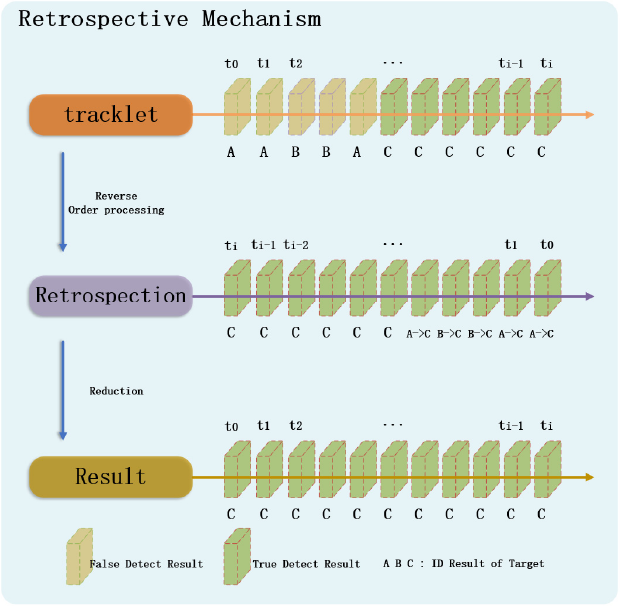
Figure 4. Schematic diagram of tracklet-based retrospective processing.